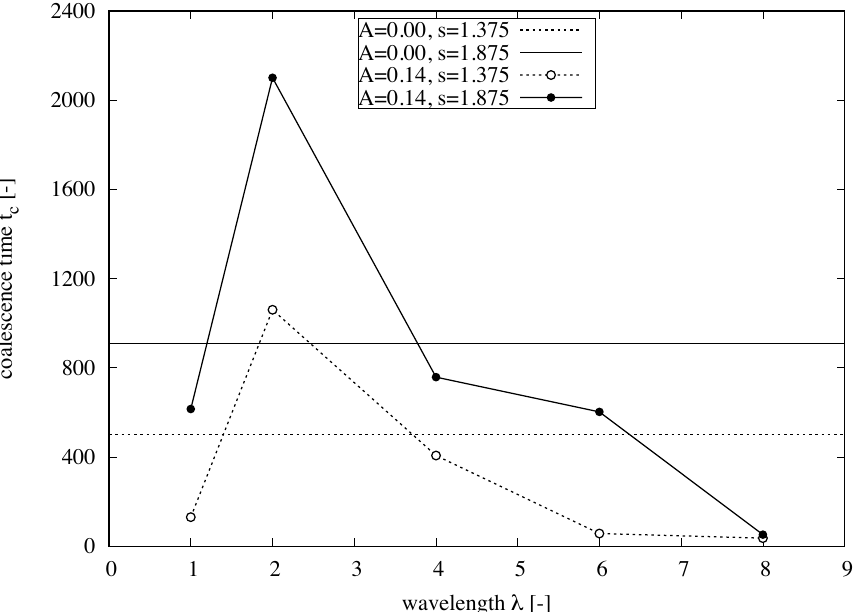
Figure 13. Trend of the coalescence time t c relative to the channel’s wavelength λ for the straight A = 0.00 and the sinusoidal A = 0.14 channels. It is noted that for wavelength λ = 2, the coalescence time t c is higher than the coalescence time for the straight channel with same parameters. The others wavelengths have presented smaller coalescence time. All parameters are